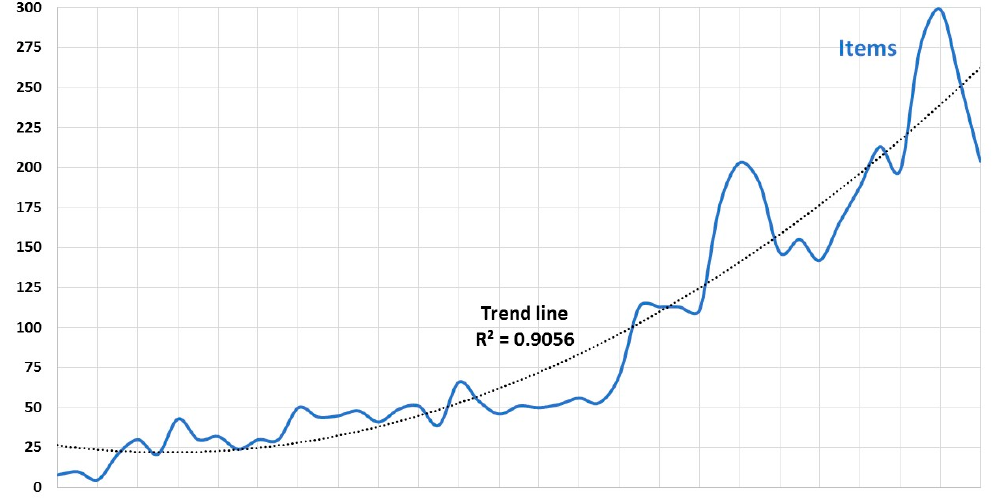
Figure 3. Trends in publications on labour relations from 1970–2016.